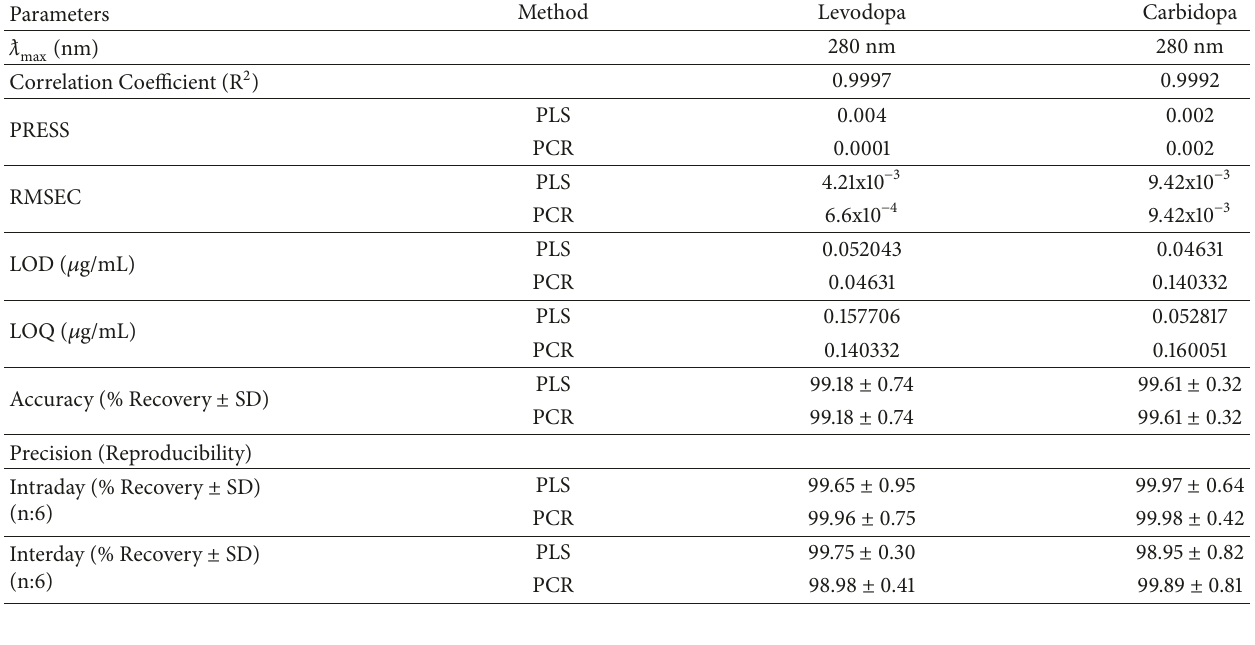
Table 3: Validation parameters for chemometric determination of levodopa and carbidopa using PLS and PCR methods. Parameters